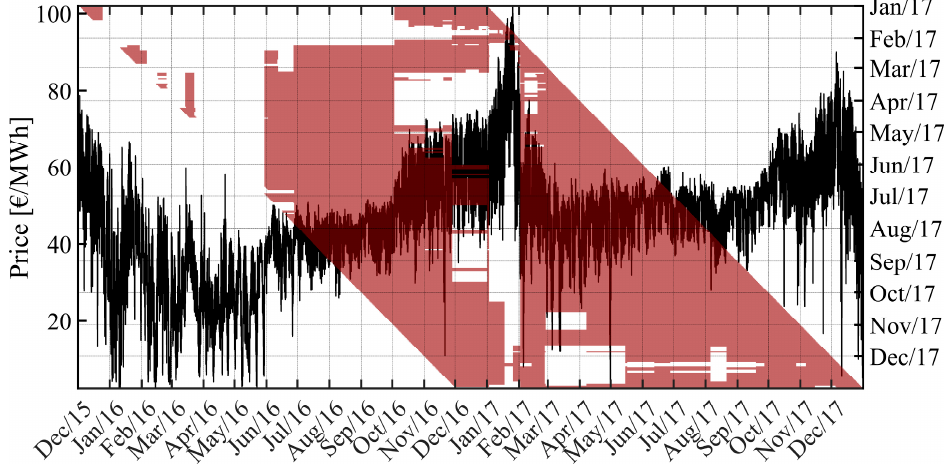
Figure 3. Structural breaks algorithm period selection.